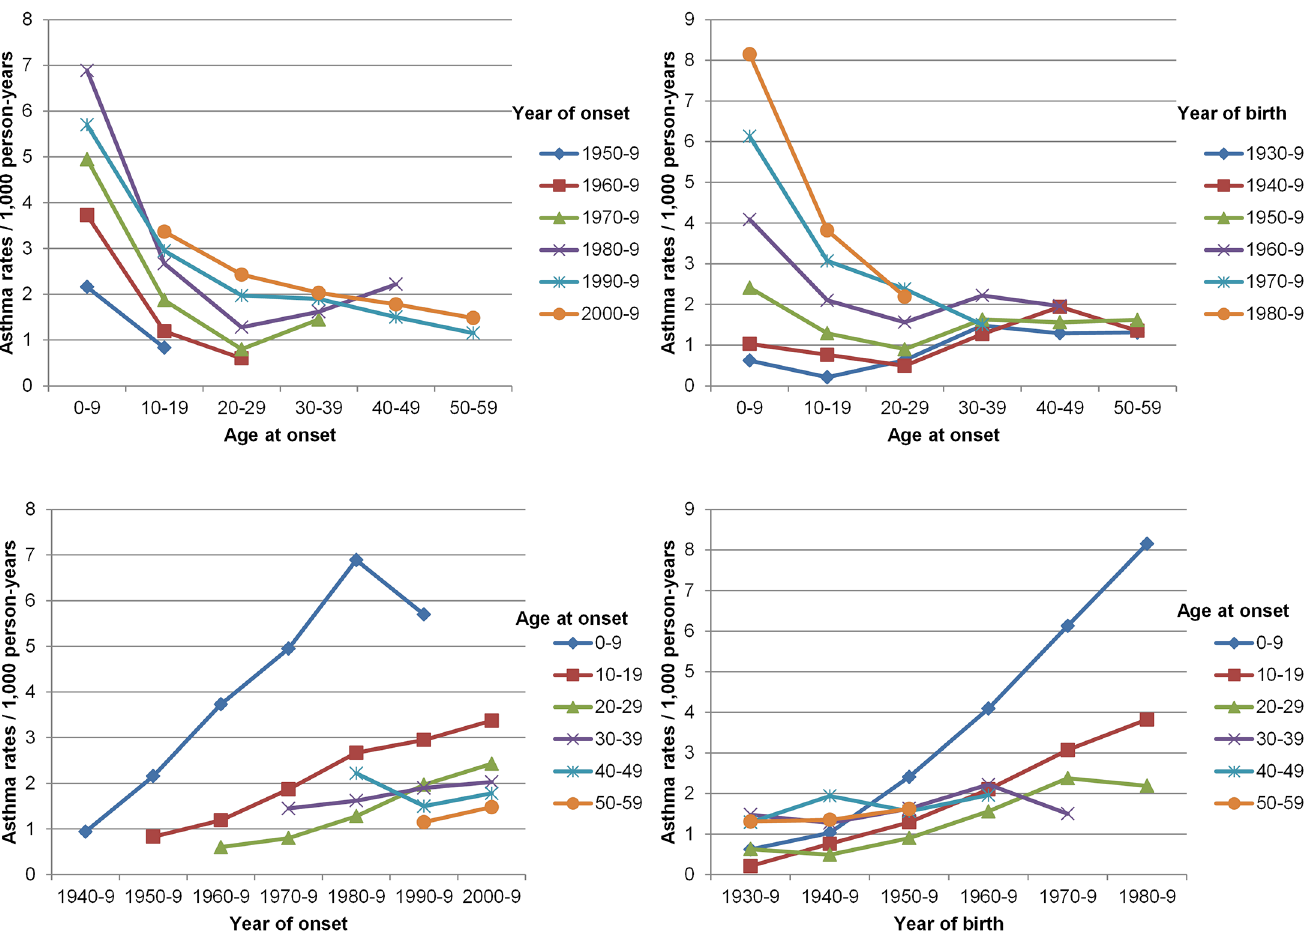
Fig 1. Age-specific rates of asthma in Italy by period of asthma onset and birth cohort: A) Age-specific rates by year of onset: age at onset on x axis, with rates corresponding to same period connected by lines; B) Age-specific rates by birth cohort: age at onset on x axis, with rates corresponding to same cohorts connected by lines; C) Period-specific rates by age: year of onset on x axis, with rates corresponding to same age groups connected by lines; D) Cohort-specific rates by age: year of birth on x axis, with rates corresponding to same age groups connected by lines.